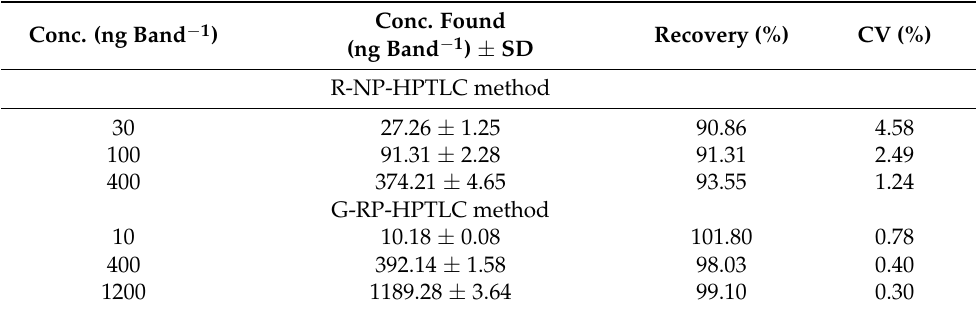
Table 3. Results for accuracy evaluation of TRV for R-NP-HPTLC and G-RP-HPTLC methods (mean ± SD; n = 6).